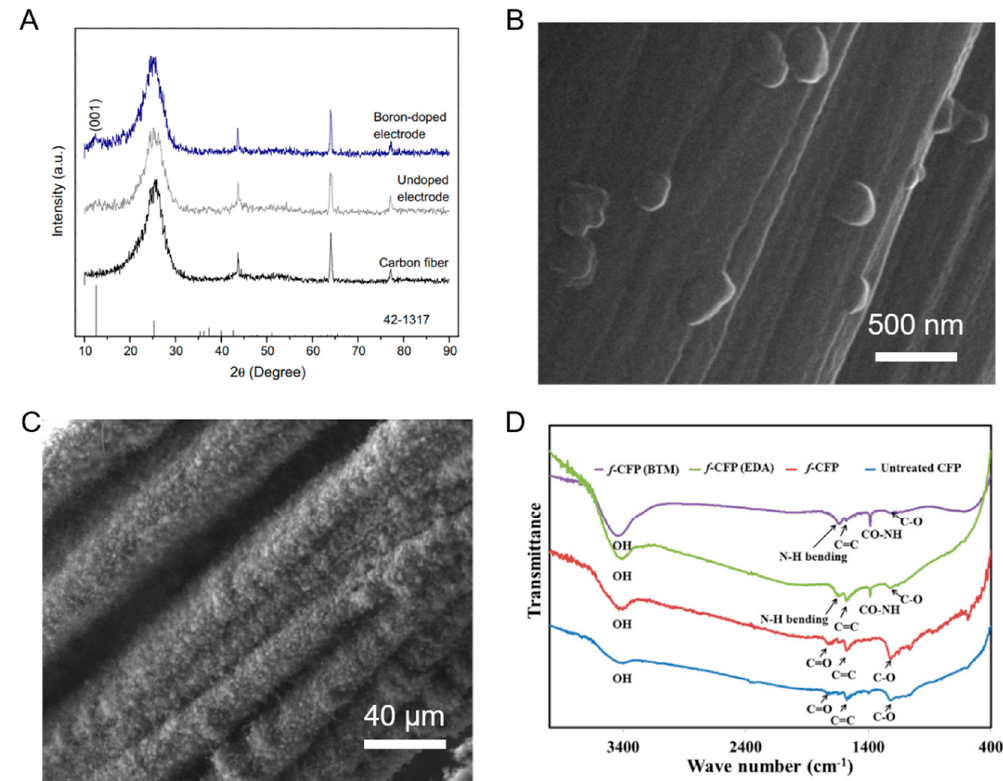
Figure 3. ( A ) XRD patterns for CF, undoped electrode and Boron-doped electrode. Reproduced with permission from [27]. ( B ) SEM image of CF / poly-2,5-dimercapto-1,3,4-thiadiazole (DMcT) / Polypyrrole (PPy) composite. Reproduced with permission from [28]. ( C ) SEM image of carbon nanotubes CNTs grown on CFs. Reproduced with permission from [29]. ( D ) FTIR spectra of bare and functionalized carbon fiber paper CFP. Reproduced with permission from